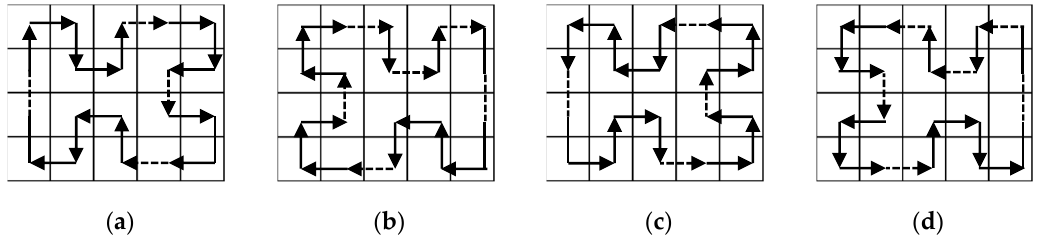
Figure 2. Four kinds of closed Hilbert orders. ( a ) Closed Hilbert order C 1 . ( b ) Closed Hilbert order C 2 . ( c ) Closed Hilbert order C 3 . ( d ) Closed Hilbert order C 4 .